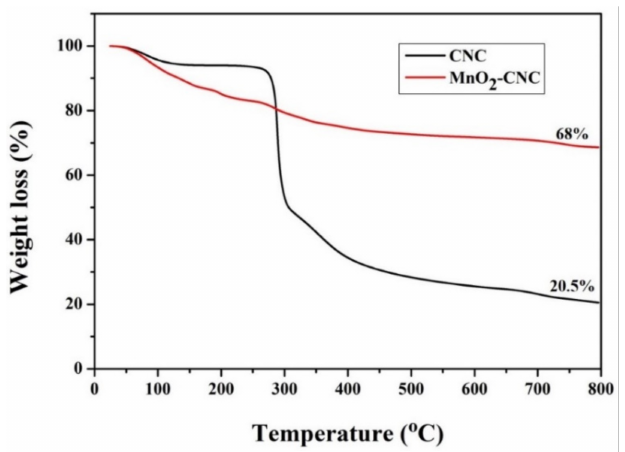
Figure 3. TGA curves of CNC and MnO 2 -CNC